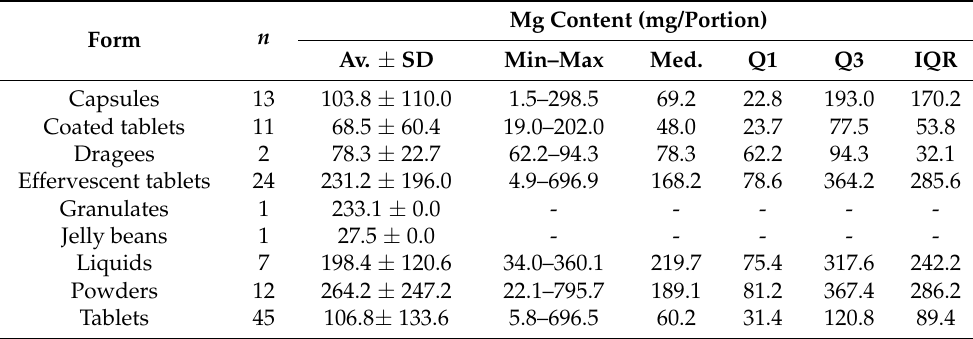
Table 2. Magnesium content (mg/portion) in food supplements depending on the pharmaceutical form.